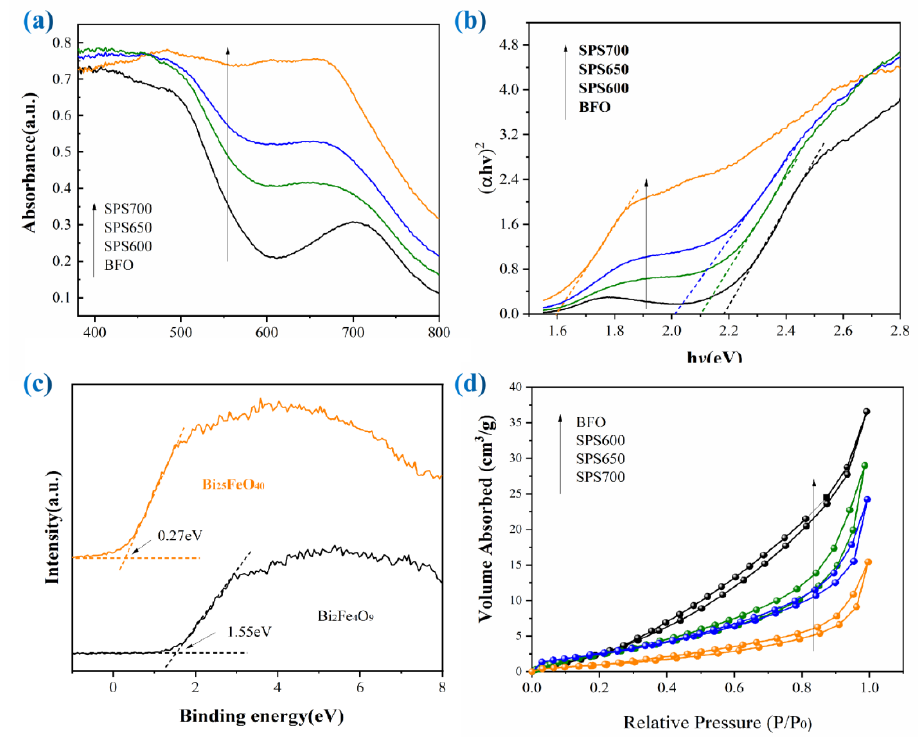
Figure 3. ( a ) The UV–Vis absorption spectrum of the as-prepared sample; ( b ) the calculation bandgap diagram of the as-prepared sample, according to Kubelka–Munk function. ( c ) The XPS VB spectra of as-synthesized Bi 2 Fe 4 O 9 and Bi 25 FeO 40 samples; ( d ) N 2 adsorption and desorption isotherms of the as-prepared samples.